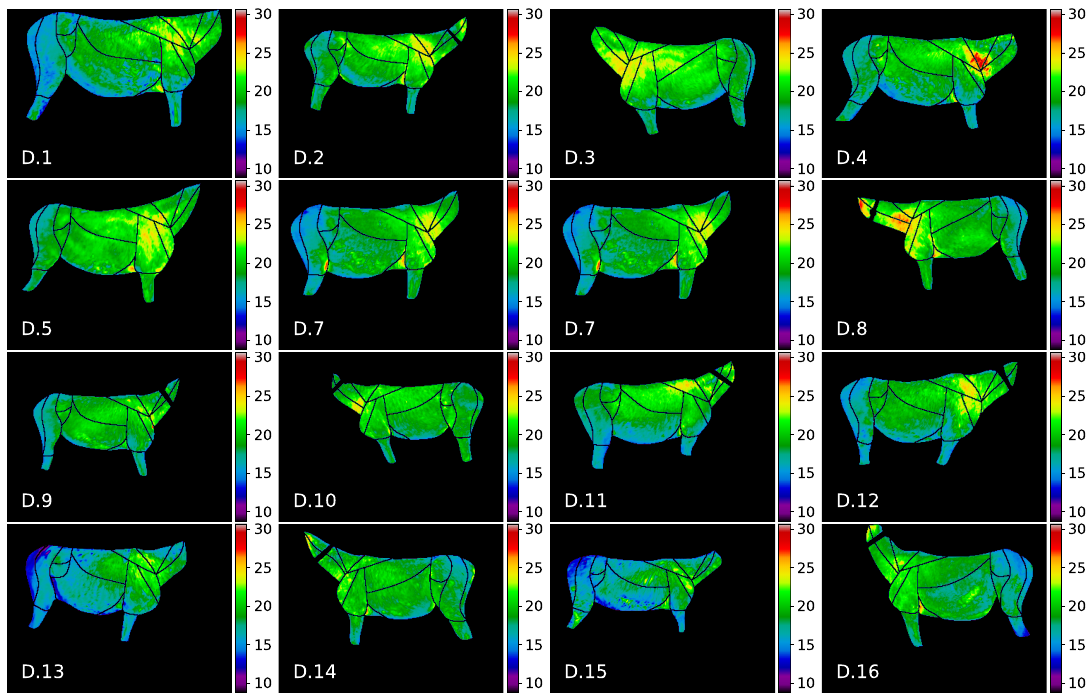
Figure 8. Thermal maps of annotated ROIs for donkeys in our